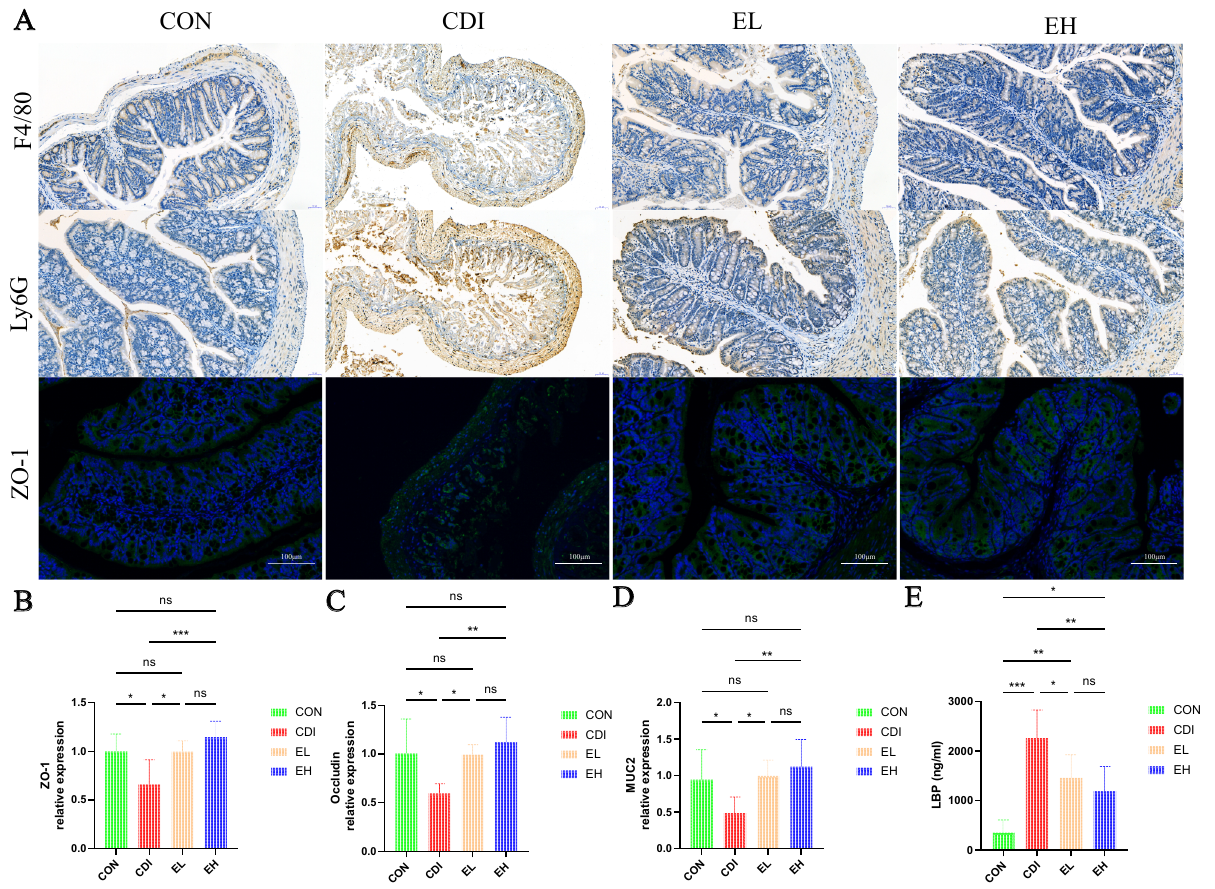
Figure 2. EGCG ameliorates C. difficile -induced impairment of the intestinal barrier. ( A ) Representa- tive images of F4/80 and Ly6G immunohistochemical staining, and immunofluorescence staining of ZO-1 (green) and the cell nucleus (blue). ( B – D ) Intestinal mRNA expression (ZO-1, Occludin, and MUC2). ( E ) Serum LBP levels. *, p < 0.05; **, p < 0.01; ***, p < 0.001; ns, p >